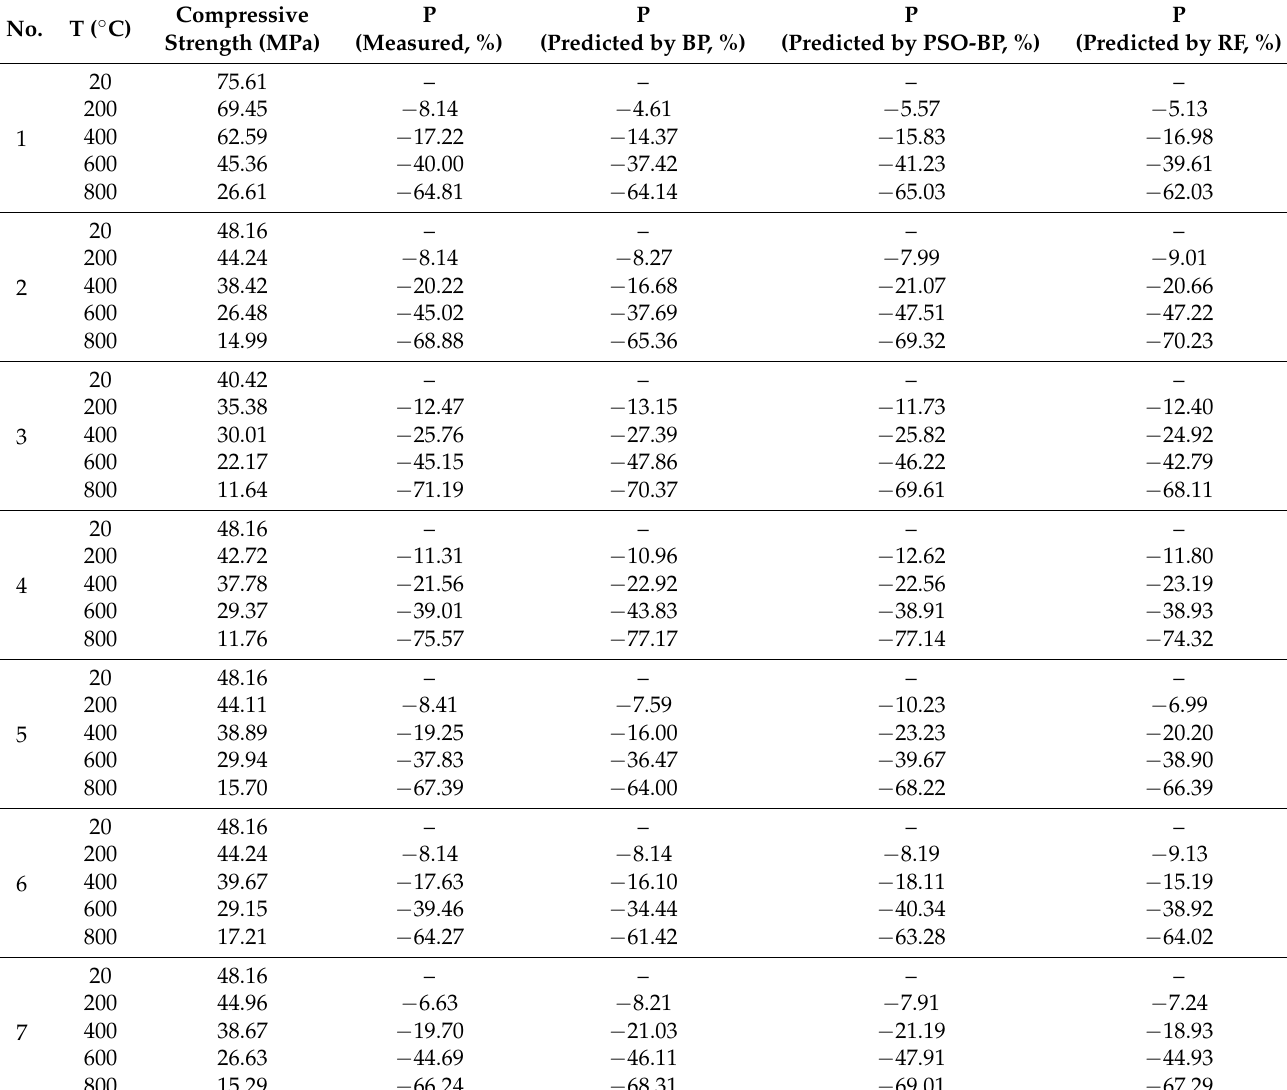
Table 6. Compressive strength loss percentages measured and